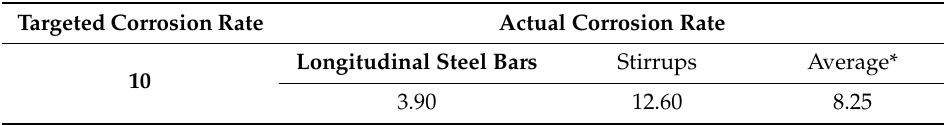
Table 3. Actual corrosion rate of reinforcements from gravimetric measurements